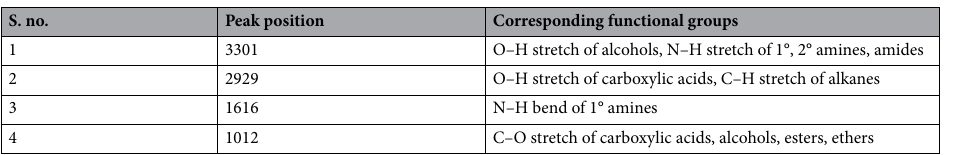
Table 1. Peak position and corresponding functional groups present in gold nanoparticles synthesized using mangostan peel extract powder.